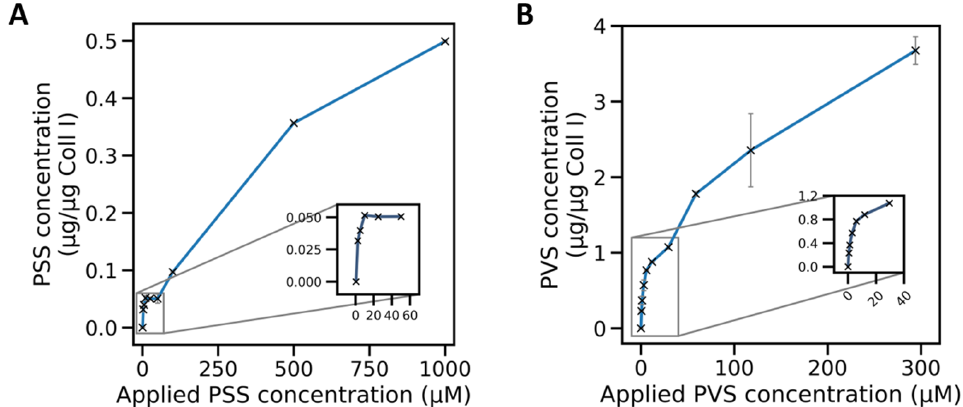
Figure 3. Kinetics of the adsorption of PSS and PVS on 3D Coll I matrices. The amount of adsorbed poly(styrene sulfonate) (PSS) ( A ) and poly(vinyl sulfonate) (PVS) ( B ) on fibrillar Coll I networks (normalized to the amount of Coll I in the network, approximately 100 μ g) in dependence on the polymer concentration in solution.